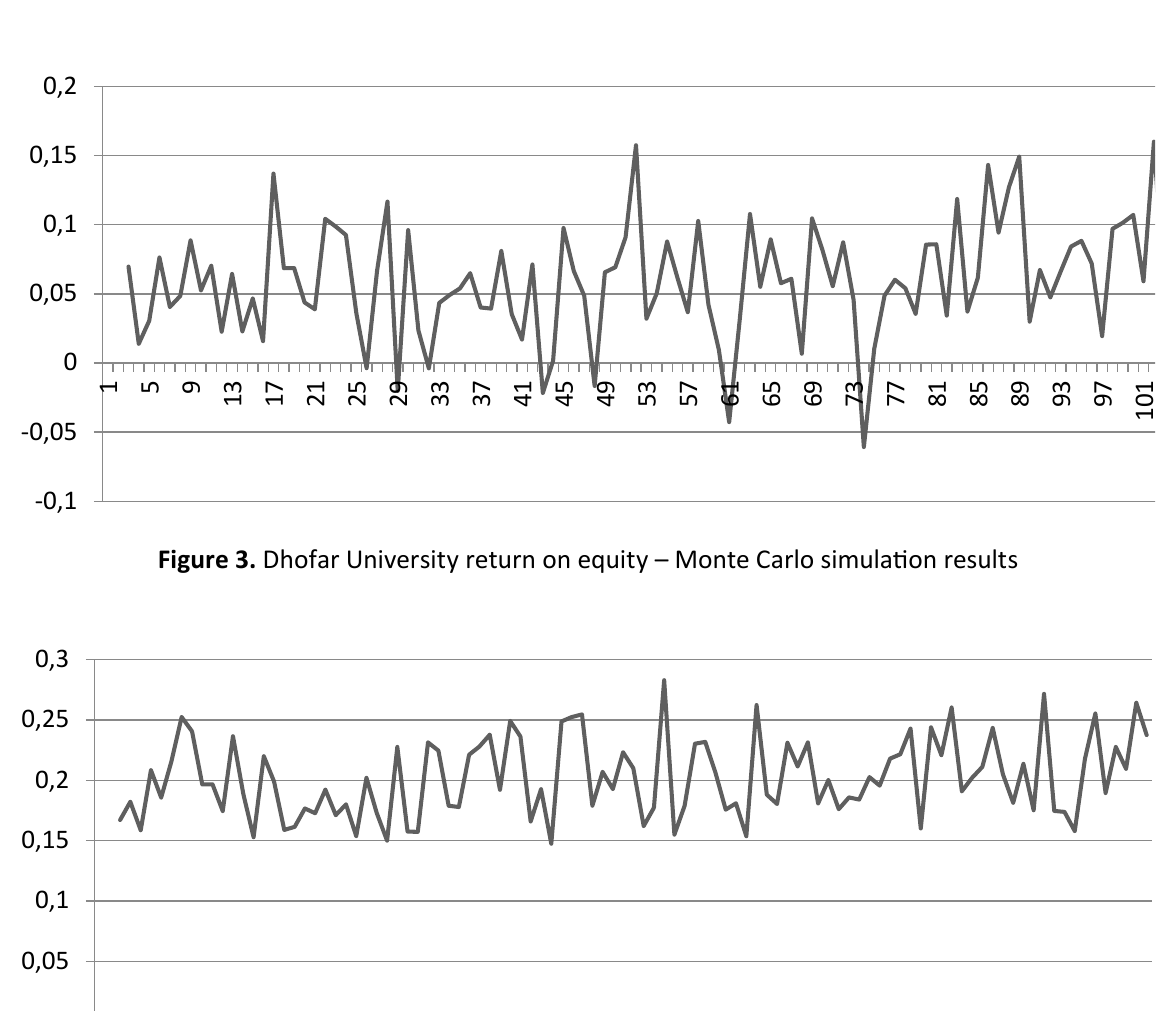
Figure 2. Dhofar University current ratio – Monte Carlo simulation results